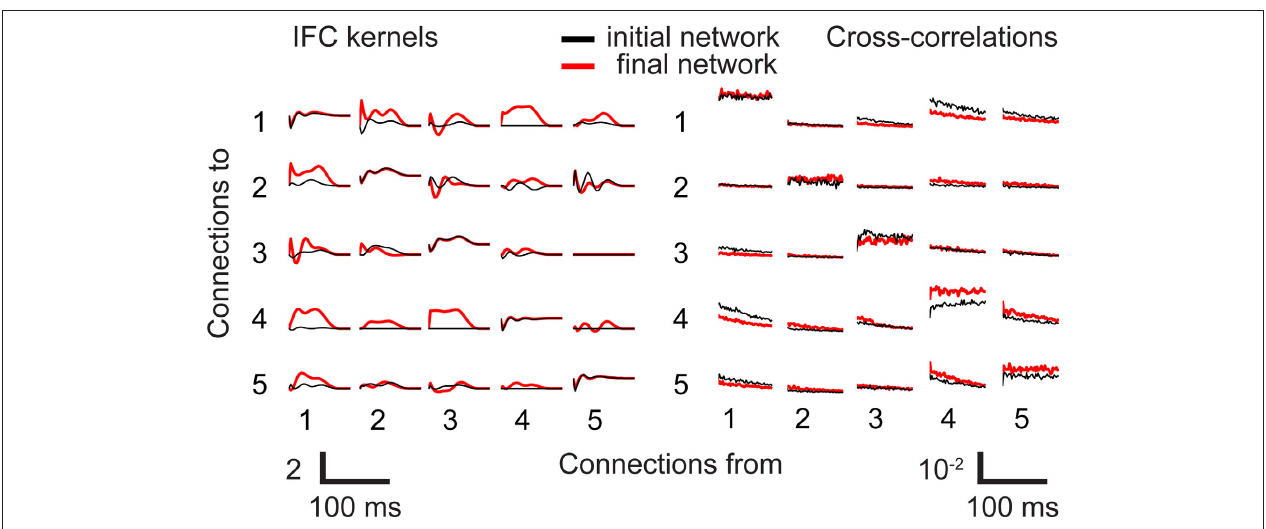
Figure 5 | Observed changes in cross-correlations and iFC kernels. IFC kernels (left) and cross-correlation functions (right) for animal BT. These functions are shown before (black) and after (red) the stimulation period. Autocorrelation scale reflecting self connections is 10 times that of the